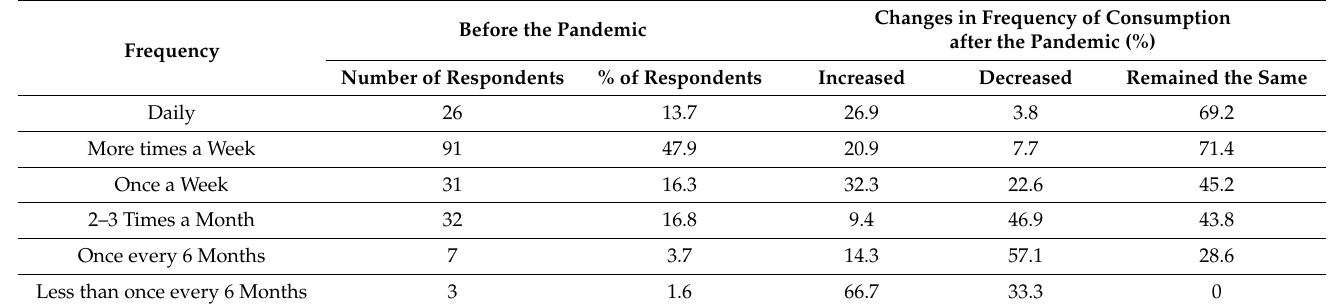
Table 5. Frequency of consuming organic food products before and after the COVID-19